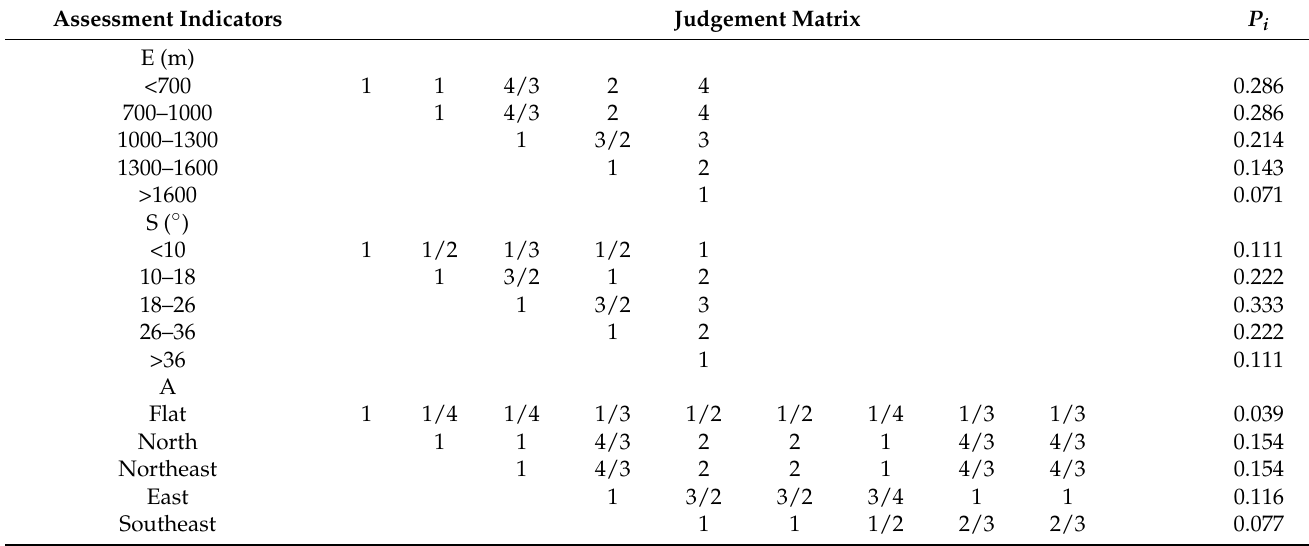
Table 3. Judgment matrix of the importance of assessment